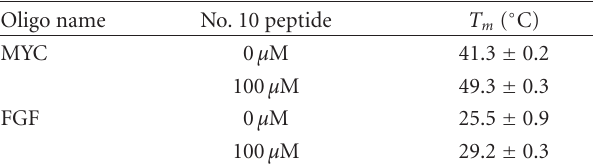
Table 2: Melting temperature ( T m ) of G-quadruplex DNAs with/ without peptide no.